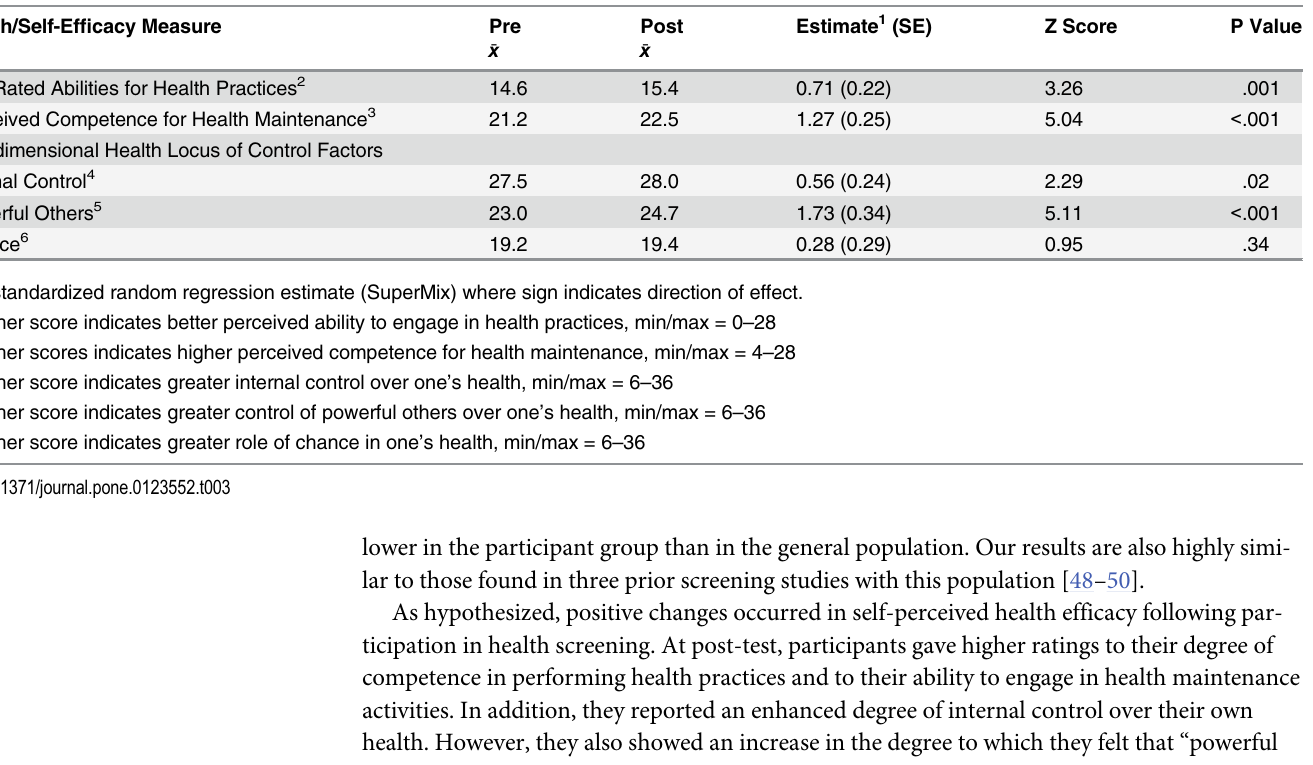
Table 3. Random regression analysis of changes in health self-efficacy among adults with serious mental illnesses pre- and post-health screen- ing, controlling for sex, age, race, education, and study site (N =